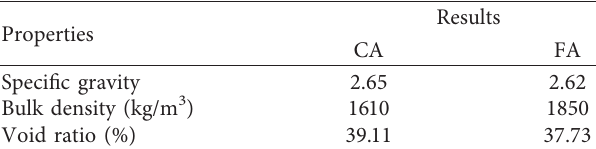
Figure 3: Geometry and shape of crimped steel fiber (corrugated Table 3: Physical properties of aggregates.